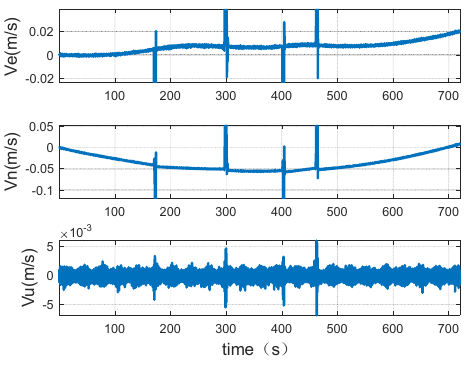
Figure 11. Speed of the trailer.